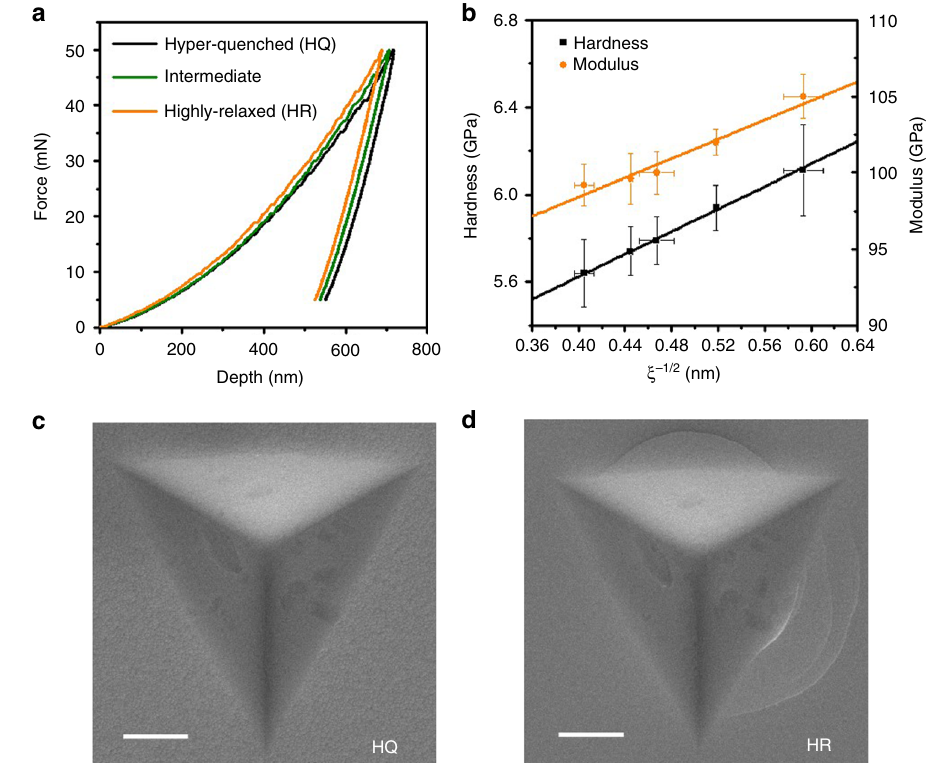
Fig. 2 Mechanical property measurements by instrumented nanoindentation. a Nanoindentation force – depth curves of the hyper-quenched, the intermediate and the highly relaxed samples. b Nanoindentation hardness and modulus plotted with the characteristic length of spatial heterogeneity. The solid curve is a linear fi tting for the points. The indenter impressions of c the hyper-quenched, and d the highly relaxed samples. Scale bar, 1 μ m. The error bars indicate standard